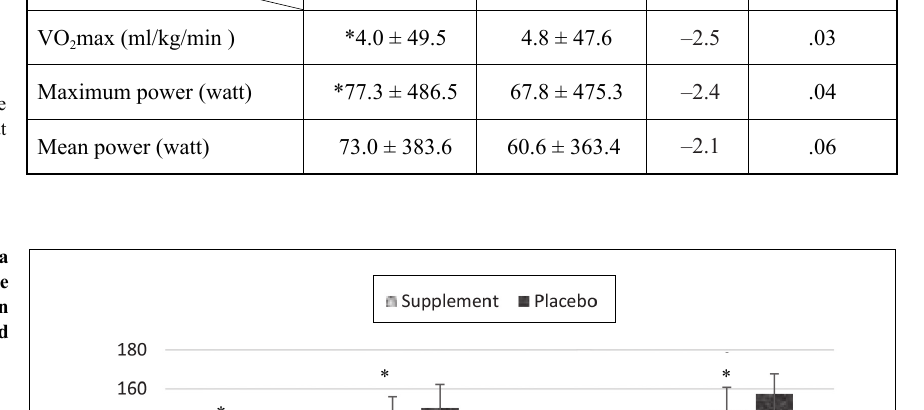
Table 2. VO 2 max, maximum and mean power (mean ± SD )